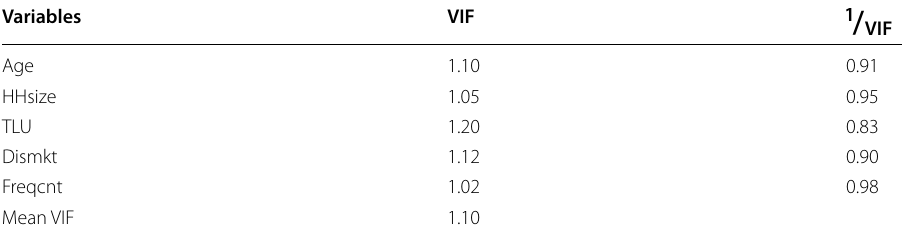
Table 5 VIF for the continuous variables used to technical inefficiency model ( n Source: Computed from Field Survey Data, 2015/16